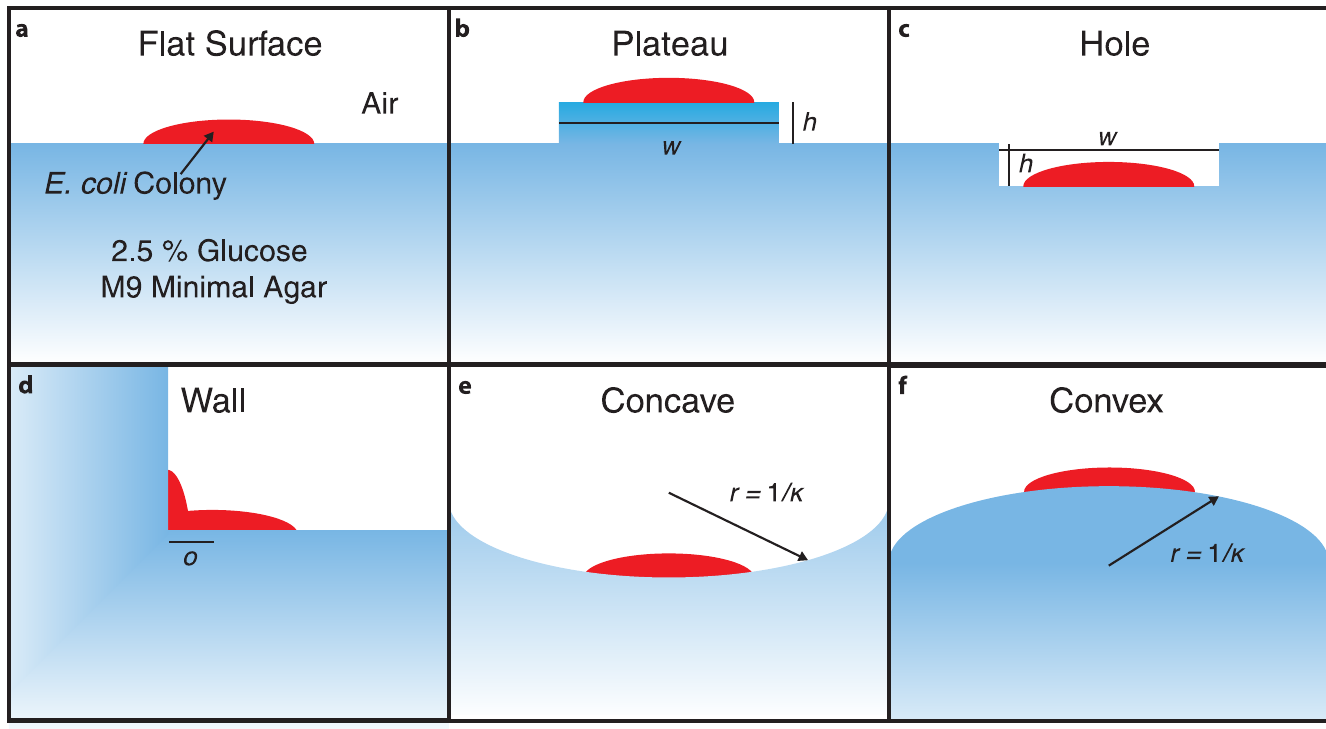
Fig 2. Geometries investigated. An illustrative schematic showingthe six geometriesexaminedin this study. Various characteristic variablesof the geometry are indicatedwith symbols. See the Methods and Results text for numerical values and descriptionsof these variables.